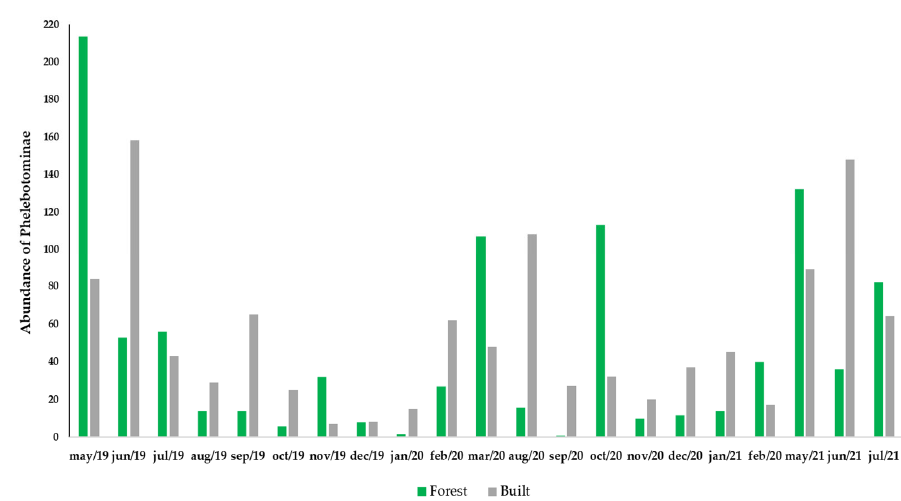
Figure 3. Rényi diversity profile of sand flies collected in the forest and urban areas from May 2019 to March 2020, August 2020 to February 2021, and March to July 2021 in the city of João Pessoa, state of Paraíba, Brazil.